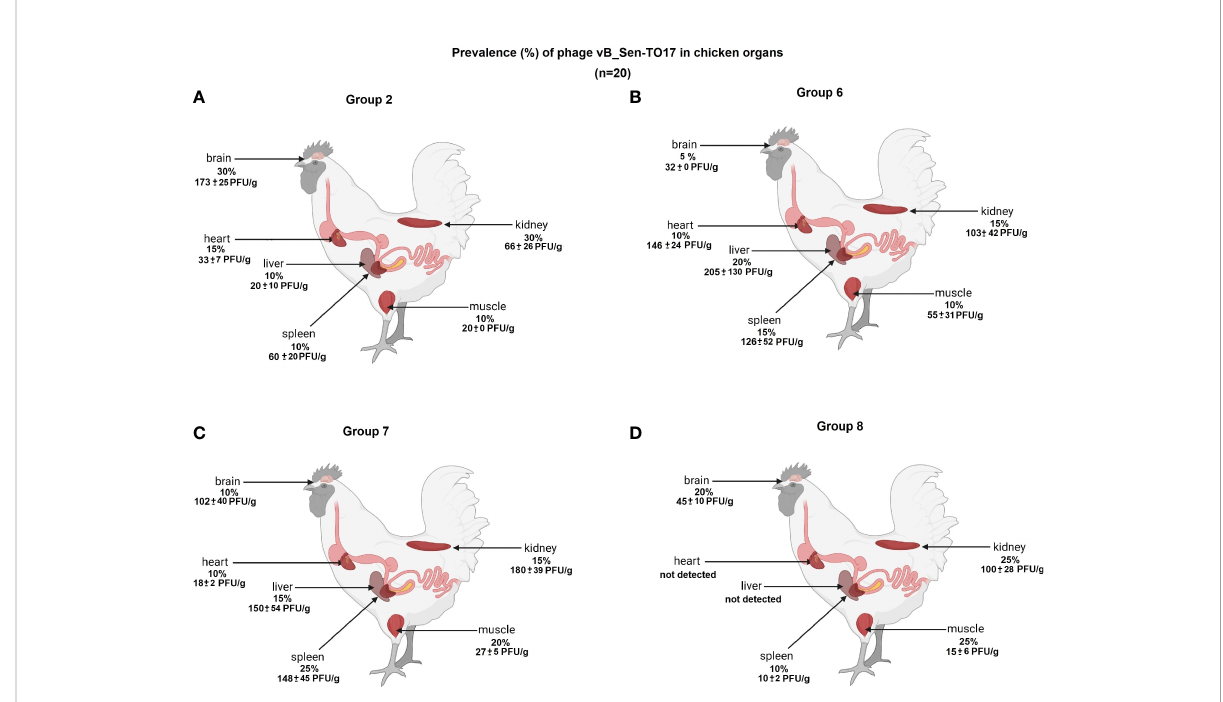
FIGURE 7 Presence of phage vB_Sen-TO17 (percent of chickens in which phages were detected is indicated; 100% = 25) in chicken organs in Groups 2 (A) , 6 (B) , 7 (C) and 8 (D) . The values represent mean phage titers (PFU/g) with SD.